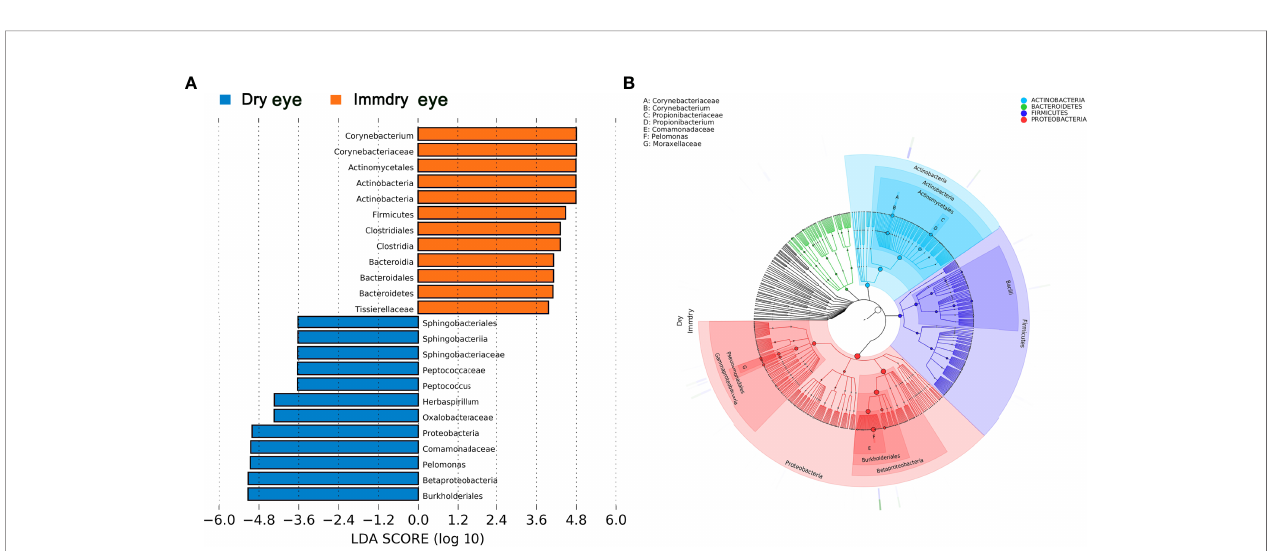
FIGURE 3 | Bacterial biomarkers identi fi ed with the linear discriminant analysis effect size (LEfSe) algorithm. (A) Linear discriminant analysis (LDA) scores with the LEfSe tool for taxa, with LDA scores >3.6 and p < 0.05 shown in the histogram. (B) Cladogram displaying the relations between taxa at different taxonomic levels. Each circle represents a hierarchy, followed by phylum, class, order, family, and genus. Different phyla are marked with different colors . The size of the nodes represents the taxon